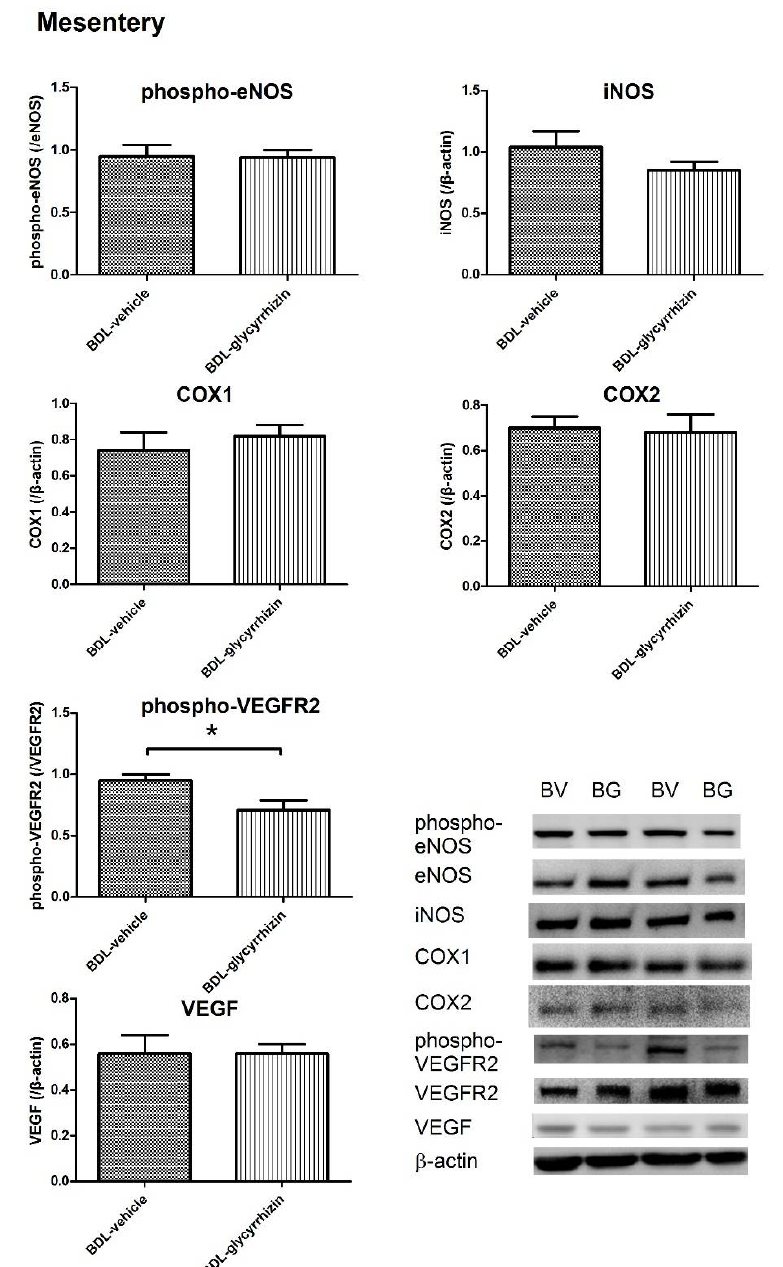
Figure 4. The angiogenic protein expressions in the mesentery. Glycyrrhizin downregulated phospho-VEGFR2 expression. VEGF, Phospho-eNOS, iNOS, COX1, and COX2 expressions were unaffected ( n = 6, 6; BC, BDL-control; BG, BDL-glycyrrhizin). * p < 0.05